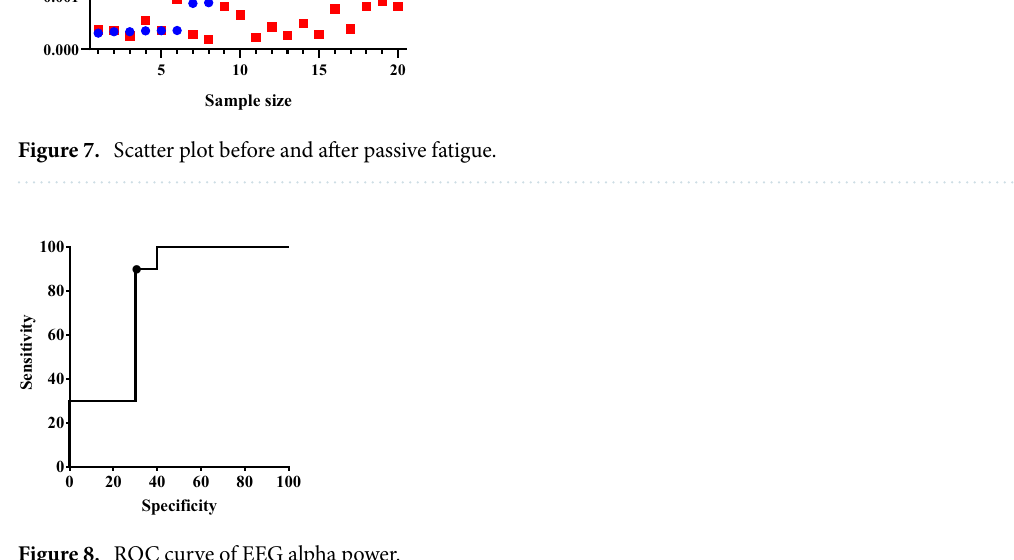
Figure 8. ROC curve of EEG alpha